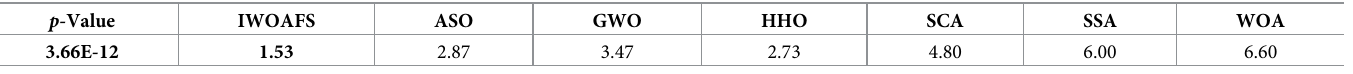
Table 12. Friedman test results for